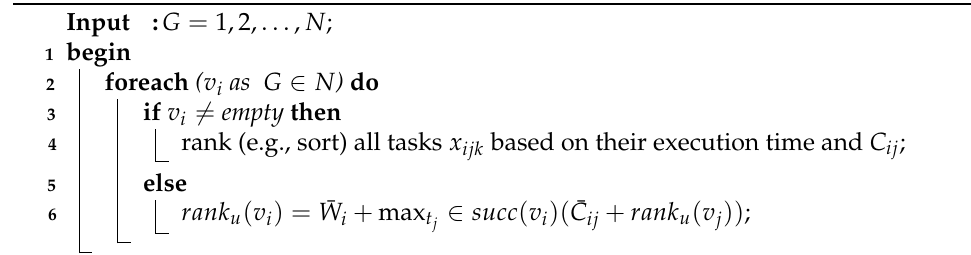
Algorithm 2: Topological Ordering Scheme.